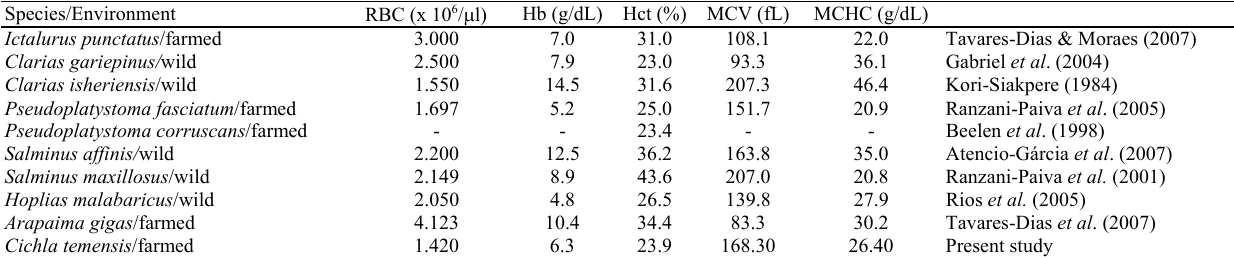
Table 3. Mean values of red blood cell parameters for different species of carnivorous fish from literature. RBC = Red blood cell counts; Hb = hemoglobin; Hct = hematocrit; MCV = Mean corpuscular volume; MCHC = Mean corpuscular hemoglobin. - = No